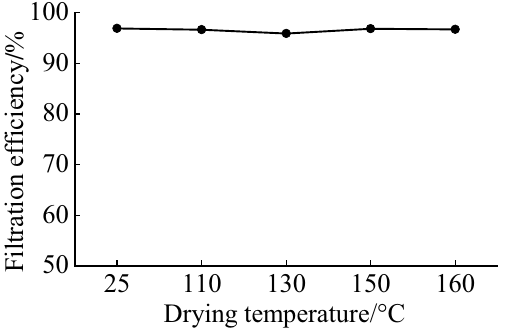
Figure 4. The influence of drying temperature on the filtration efficiency of